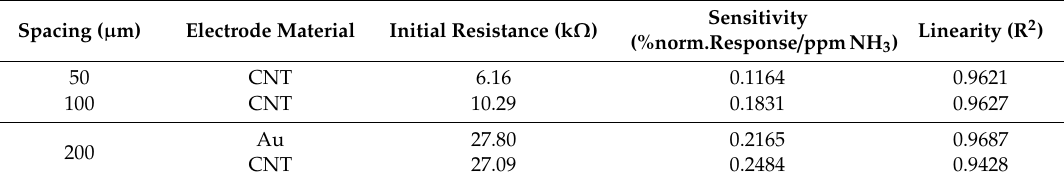
Table 1. Sensitivity towards NH 3